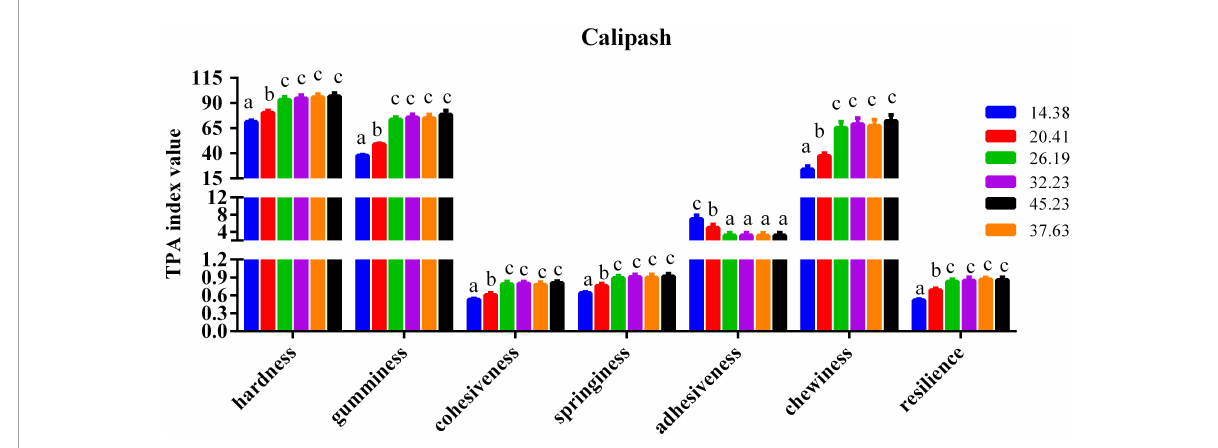
FIGURE3 Flesh quality in the calipash of juvenile softshell turtles fed a gradient of dietary supplementary protein levels for 8 weeks. Bars with different letters indicate significant differences among the groups ( P < 0.05). The values shown are the mean ± SD for three